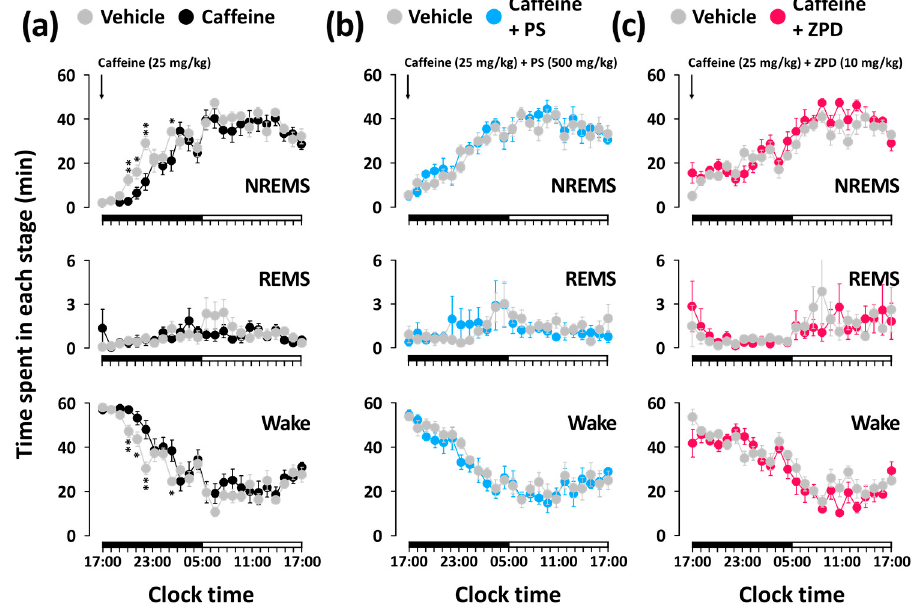
Figure 3. Temporal changes in NREMS, REMS, and Wake in C57BL/6N mice over 24 h after oral administration (per os) of caffeine alone ( a ) and co-administration of PS ( b ) or ZPD ( c ) with caffeine. Grey circles indicate the baseline day (vehicle administration). Each circle represents the hourly mean ± standard error of the mean amount of each stage (n = 7–8 per group). * p < 0.05 and ** p < 0.01, significantly different from the vehicle control (unpaired Student’s t -test). The horizontal filled and open bars on the X-axis (clock time) indicate the 12 h dark and light periods, respectively. NREMS, non-rapid eye movement sleep; PS, a standardized phlorotannin supplement; REMS, rapid eye movement sleep; Wake, wakefulness; ZPD, zolpidem.